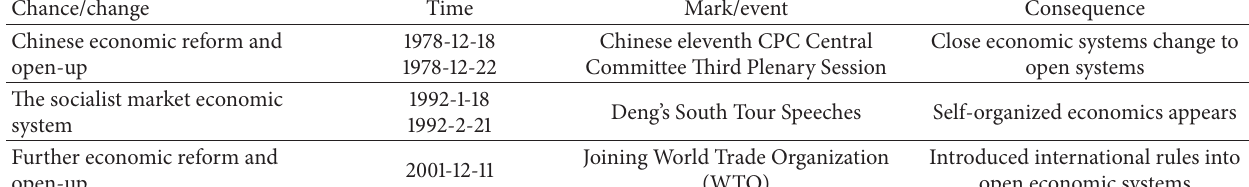
Table 6: Important historical events associated with urban evolution of China.